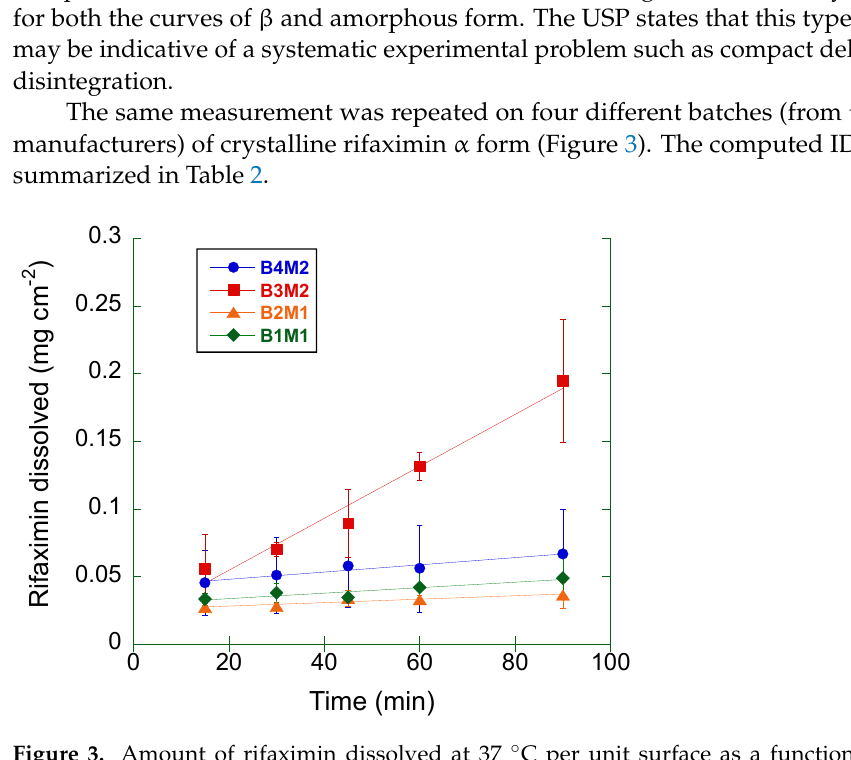
Figure 3. Amount of rifaximin dissolved at 37 °C per unit surface as a function of time from four different batches of rifaximin α form. The solid lines represent the linear regression of the experimental points. The bars represent the standard deviation (n = 3). Table 2. Intrinsic Dissolution Rate (IDR) and coefficient of the linear regression of the experimental points (R 2 ) of the four α rifaximin samples. Mean value ± standard deviation (n = 3).